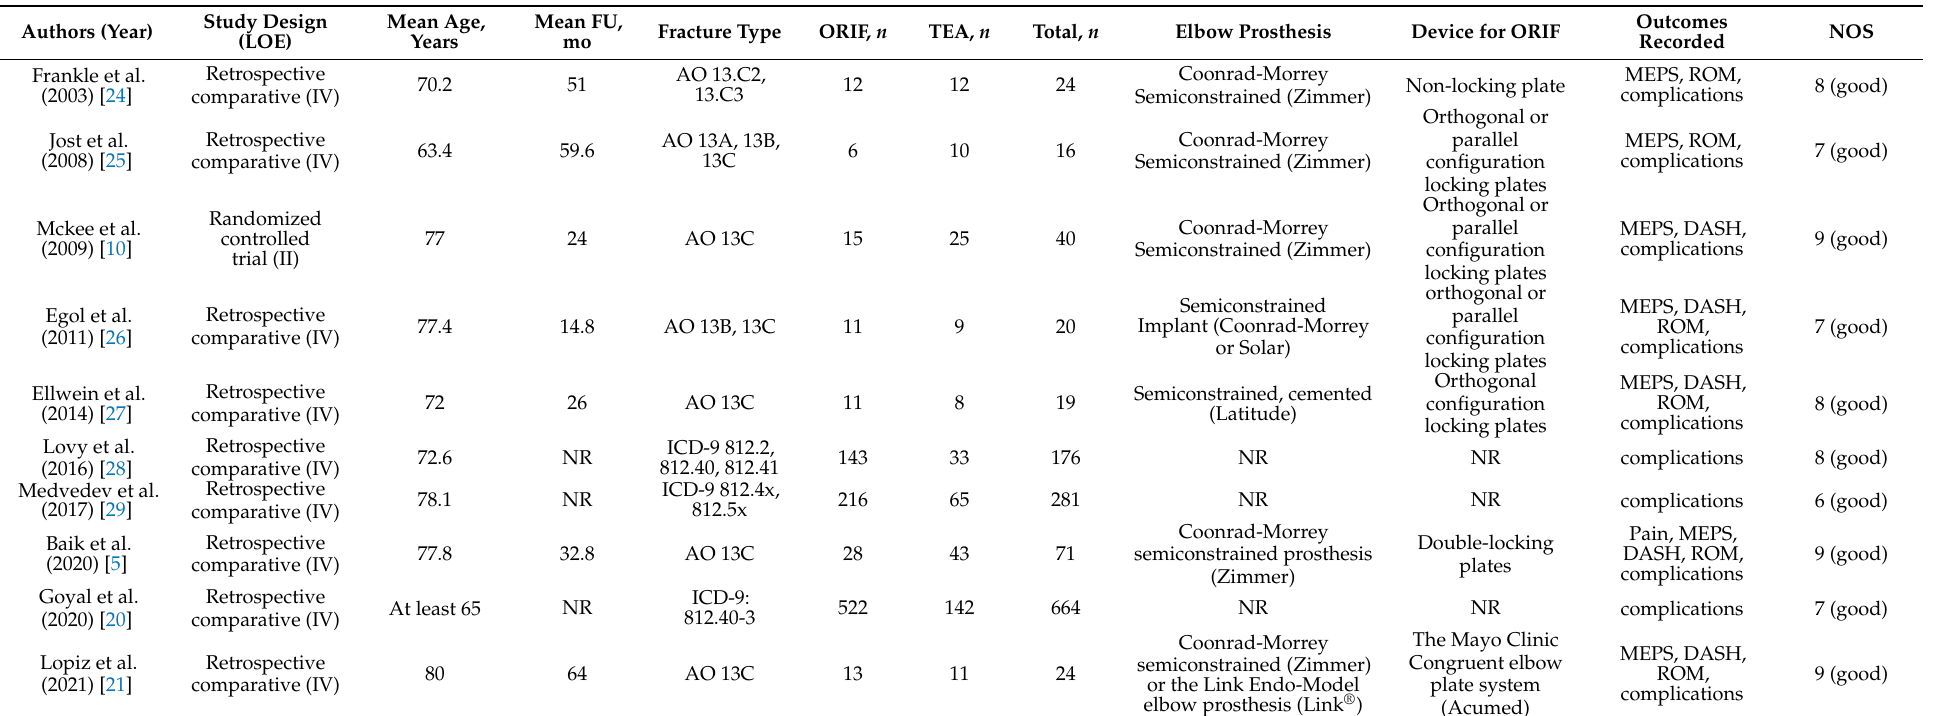
Table 1. Characteristics of the included